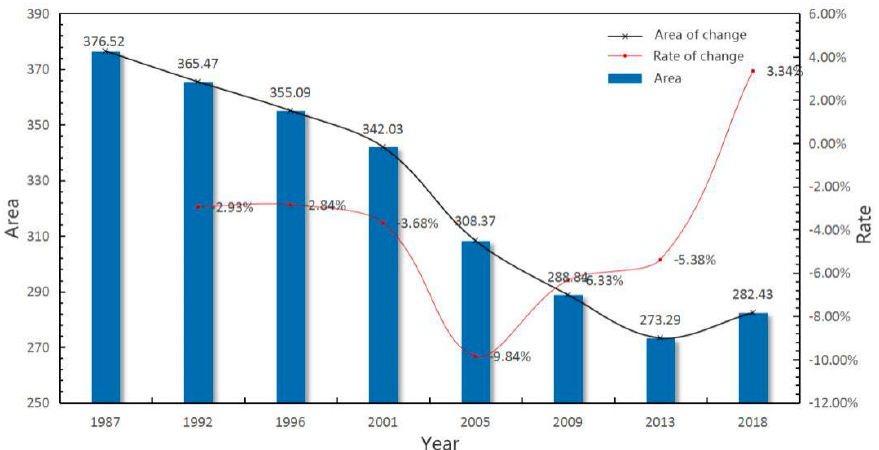
Figure 3. The total area of lakes in Wuhan’s urban development area (1987–2018). The comparison of the statistical data of lake area every four years indicates that the overall lake area initially decreased year by year and then slightly increased. The total area changed from 376.52 km 2 in 1987 to 282.43 km 2 in 2018, decreasing by 94.09 km 2 in 30 years.